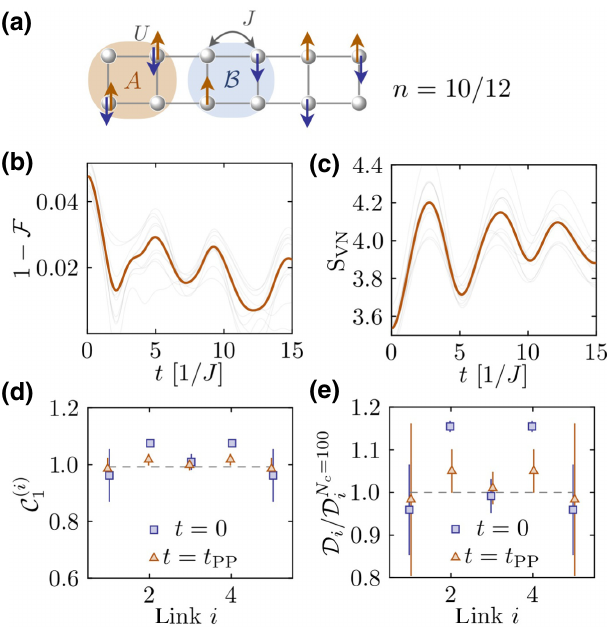
FIG. 12. Results for PP on a Hubbard ladder. (a) Sketch of the FIG. 13. Analogous plots to Fig. 12 for a 2 × 6 Fermi- 2 × 5 Fermi-Hubbard ladder at n = 0.8. (b) Fidelity [Eq. (10) in Hubbard ladder. The initial state is a random superposition of main text] computed between a bulk subsystem ( B ) [see (a)] and the two lowest-lying energy eigenstates. The quench is repeated a corresponding subsystem in the ground state of a 2 × 100 lad- ten times to gather statistics for different random initial der, during time evolution with the deformed Hamiltonian. The gray lines show the results for 50 different initial states given by a uniform random superposition of the two lowest Hamilto- nian eigenstates. The bold solid line represents the mean over all experiments for different initial states. (c) Analogous plot to (b) for the von Neumann entanglement entropy of the subsystem A indicated in (a). (d) Average nearest-neighbor hopping correla- (cid:2) = (cid:7) c † tion function in the x direction C ( i ) c ( i + 1 ) ,1, σ (cid:3) + c.c., σ 1 i ,1, σ computed in the upper leg of the ladder at the initial ( t = 0) and the optimal time ( t = t PP ). The dashed line represents the value from the center of a 2 × 100 ladder. (e) Nearest-neighbor d -wave (cid:9) (cid:3) at t = 0 and t = t pair correlations D i = Re (cid:7) (cid:9) † PP . The plot i + 1 i obtained from averag- shows the ratio between D i and D N c = 100 i ing over a small bulk region in the central region of the ground state of a 2 × 100 ladder.